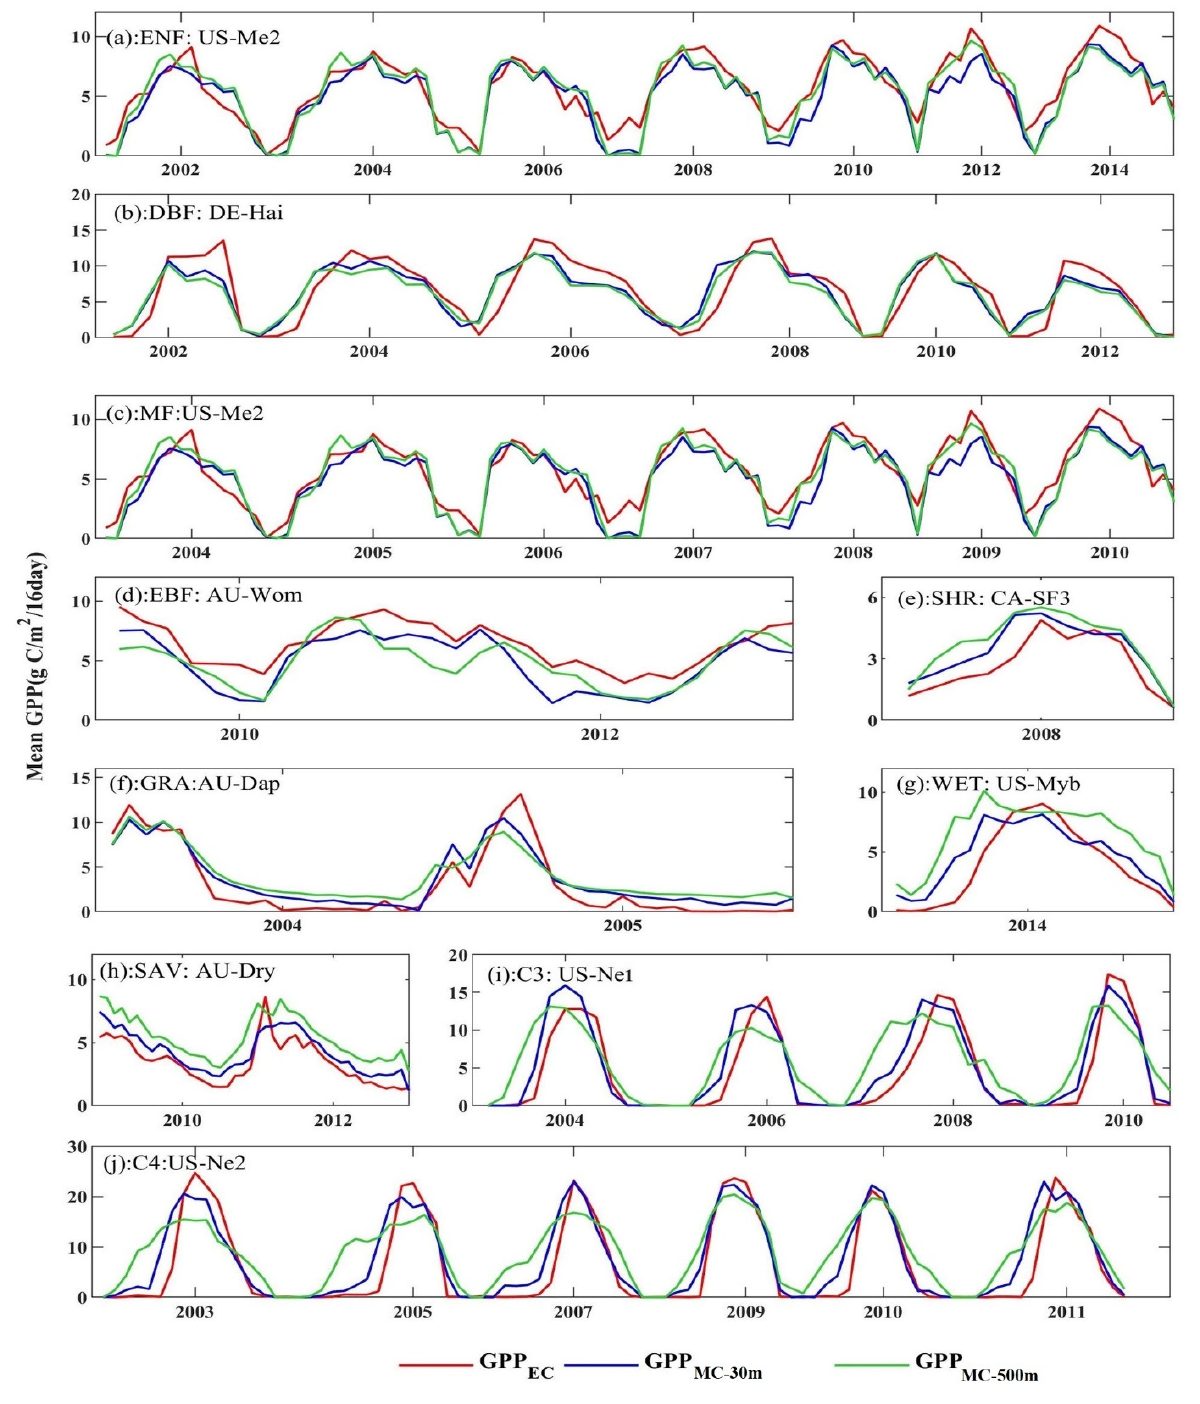
Figure 7. The seasonal cycles of estimated GPP using the optimized parameters (GPP MC-30m and GPP MC-500m ) at different spatial scales against tower GPP (GPP EC ) at 10 sites over 16-day time